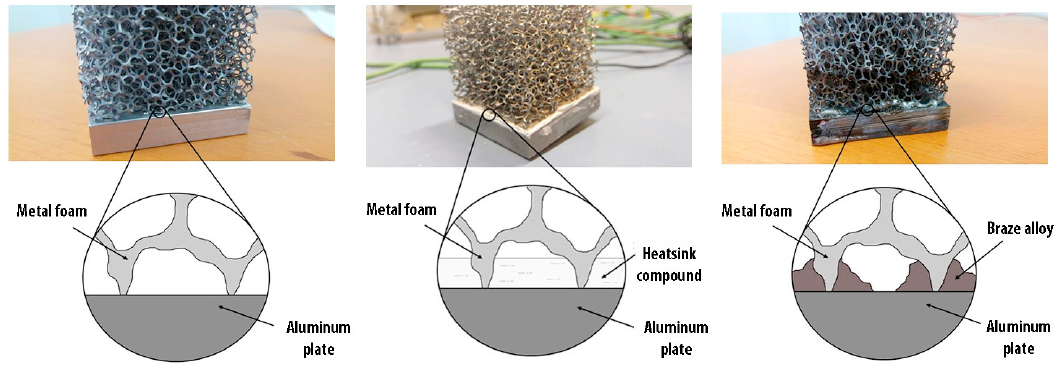
Figure 2. Schematic representation of the contact between foam and plate. From the left: (1) simple contact, (2) grease paste contact, (3) brazed contact.